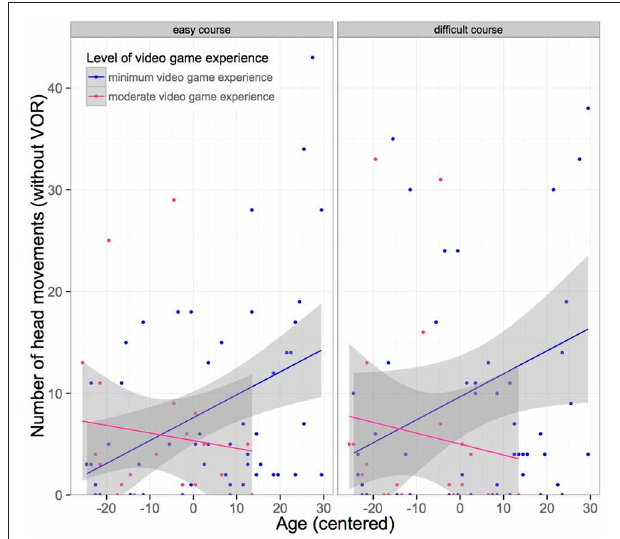
FIGURE 7 | Measure of the number of head movements without accounting for vestibulo-ocular reflexes (VOR) shown separately for both type of courses (easy vs. difficult). Older subjects performed significantly more head movements than younger subjects. However, elderly with moderate video game experience, performed less head movements ( n =